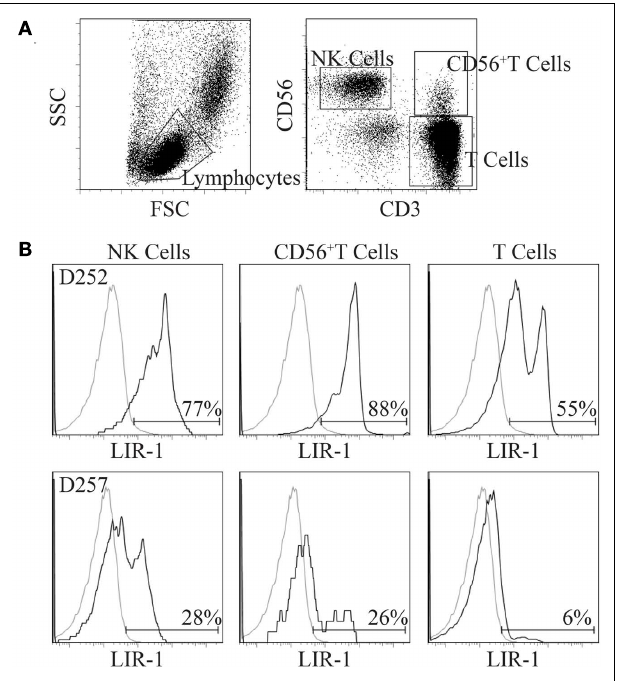
FIGURE 1 | Comparison of LIR-1 expression on primary peripheral blood lymphocyte subsets. Freshly isolated PBMC were stained with antibodies to LIR-1, CD3, and CD56. See the Section “Materials and Methods” for details. (A) The gating strategy depicted was used to generate the LIR-1 staining profiles for the three lymphocyte subsets shown. (B) Representative results for a high donor D252 (top row) and a low donor D257 (bottom row) based on NK cell LIR-1 expression are